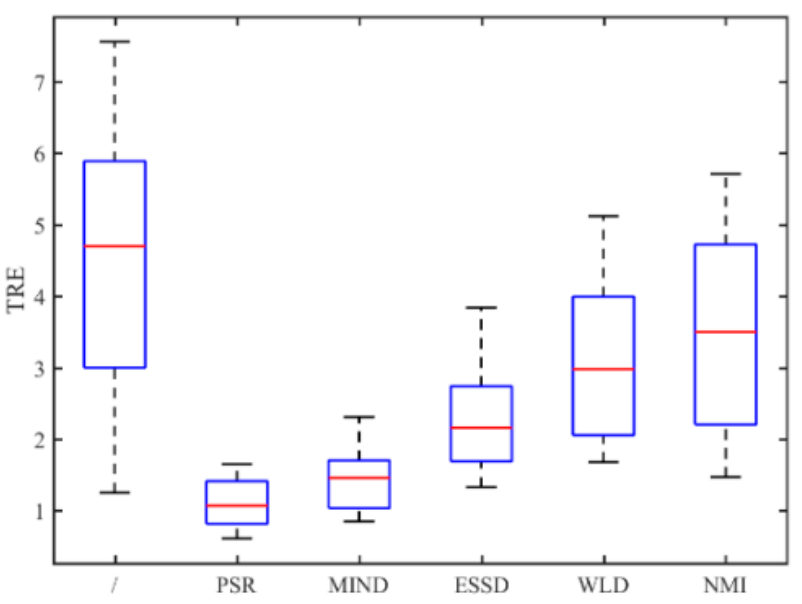
Figure 14. TRE for all registration methods performed on the RIRE dataset.